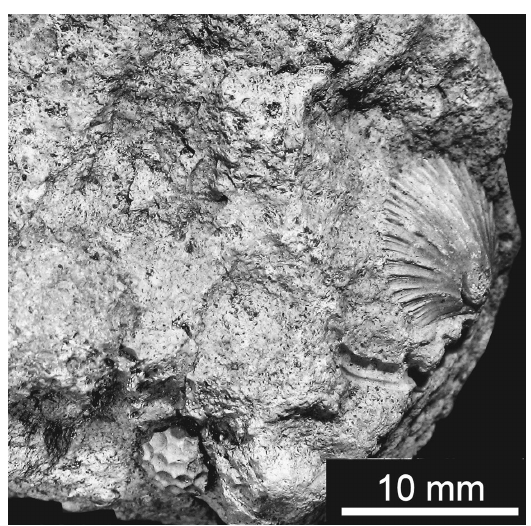
Fig. 13. Natural surface of a fragment of a type 2A boulder. Bottom: a specimen of Cyclocrinites porosus showing the membrane under the vanished globella; right: orthid brachiopod, interior mould of ventral valve. RGM 1317650, Wilsum.